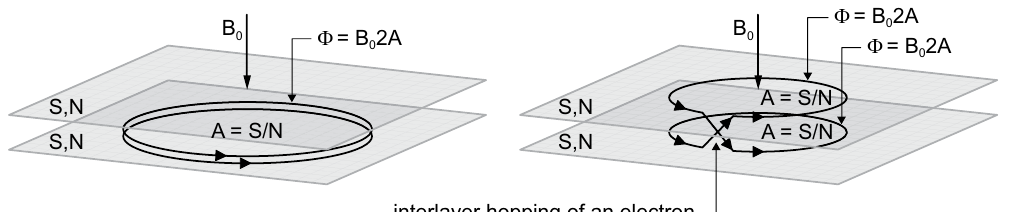
Figure 3. If a 2-loop orbit is distributed among two sheets (right), then the sizes of both loops are the same as that of a single loop (in the figure, A = S / N , as for v = 1 at B 0 ), but if both loops are placed in a single sheet, the double planar orbit is twice as large (left). This results in different commensurabilities in those two situations at the same magnetic